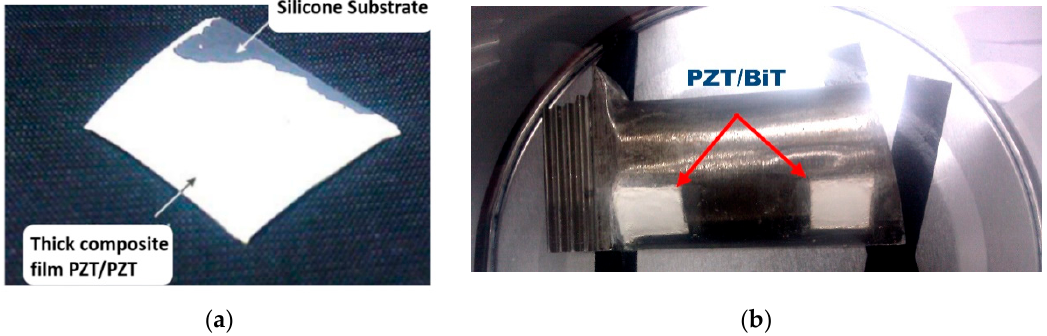
Figure 2 . ( a ) 5-layer PZT/PZT on flat silicon substrate and ( b ) 5-layer PZT/bismuth titanate (BiT) composite film on curved superalloy substrate, both derived from PMOD sol-gel method.